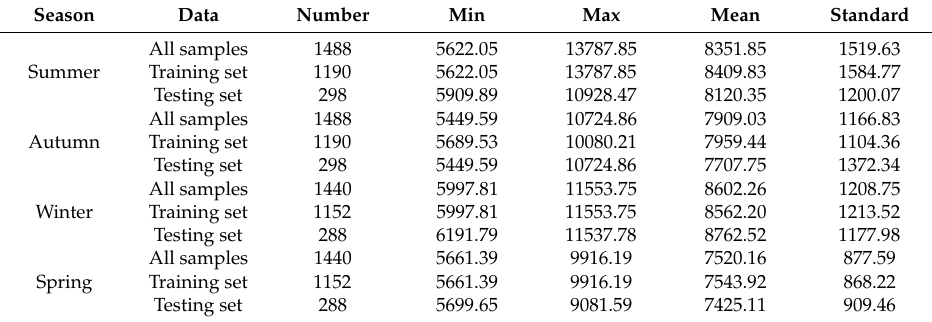
Table 3. Statistical description of the NSW seasonal power load data